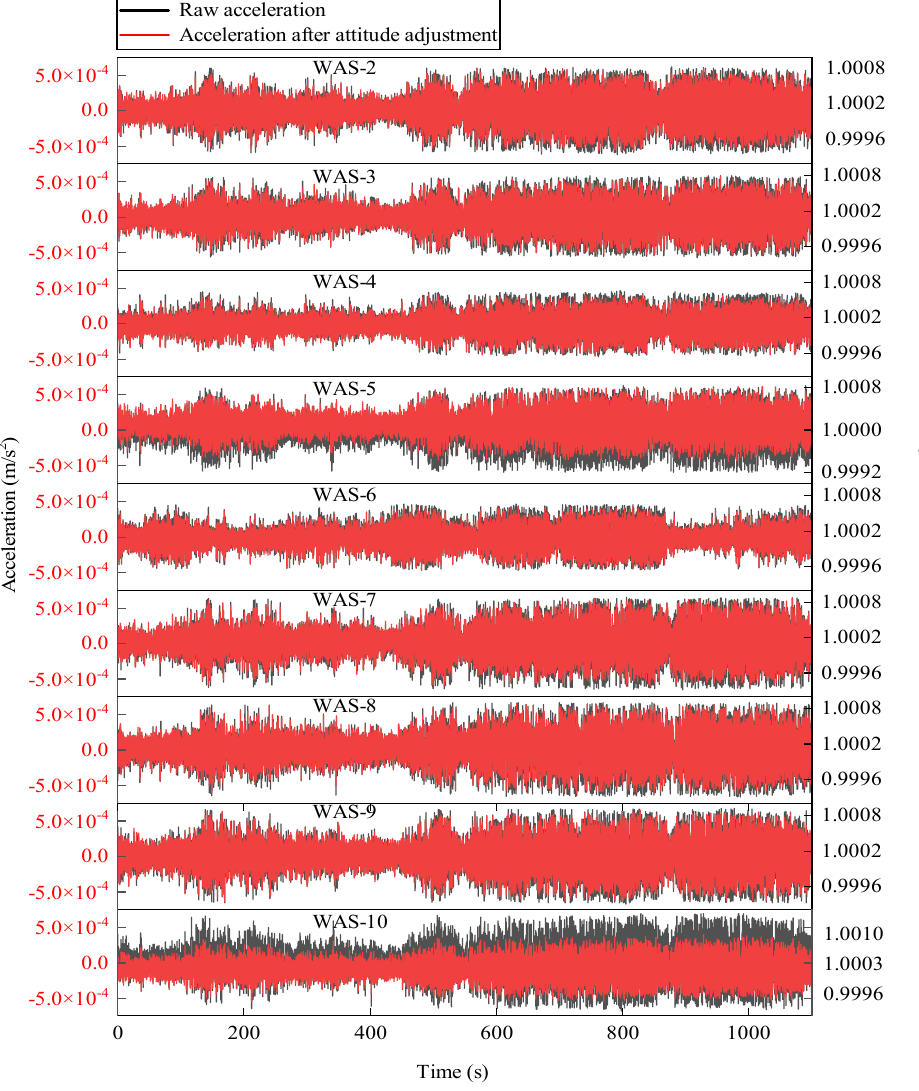
Figure 17. Processed acceleration sets after sensor attitude adjustment.